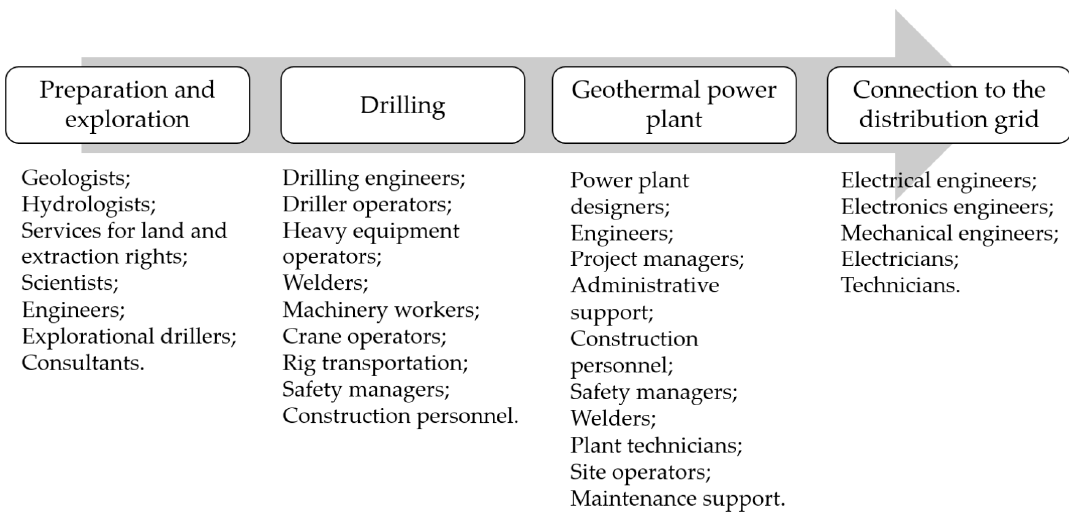
Figure 9. Example of personnel required for each phase of the geothermal plant development.